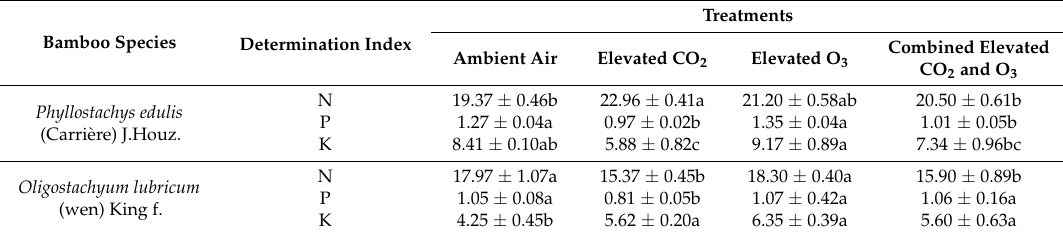
Table 2. Leaf nutrient concentrations (g/kg DM) (mean ± s.d., kg DM) of Phyllostachys edulis and Oligostachyum lubricum in response to ambient air, elevated O 3 , CO 2 and combined elevated O 3 and CO 2 . Different letters indicate significant differences among treatments ( p <